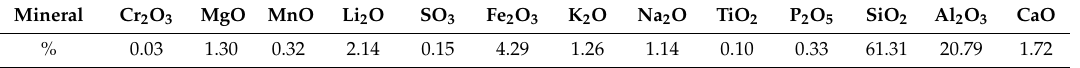
Table 1. The mineralogical composition of a typical spodumene ore sample.